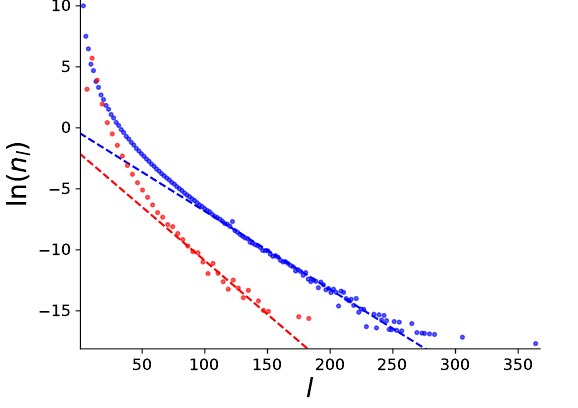
Figure 4 . Log-linear plot of number density of open strings (blue) and closed strings (red) vs. length l . The parameters of the dashed fitting curves are given in (4.13) and